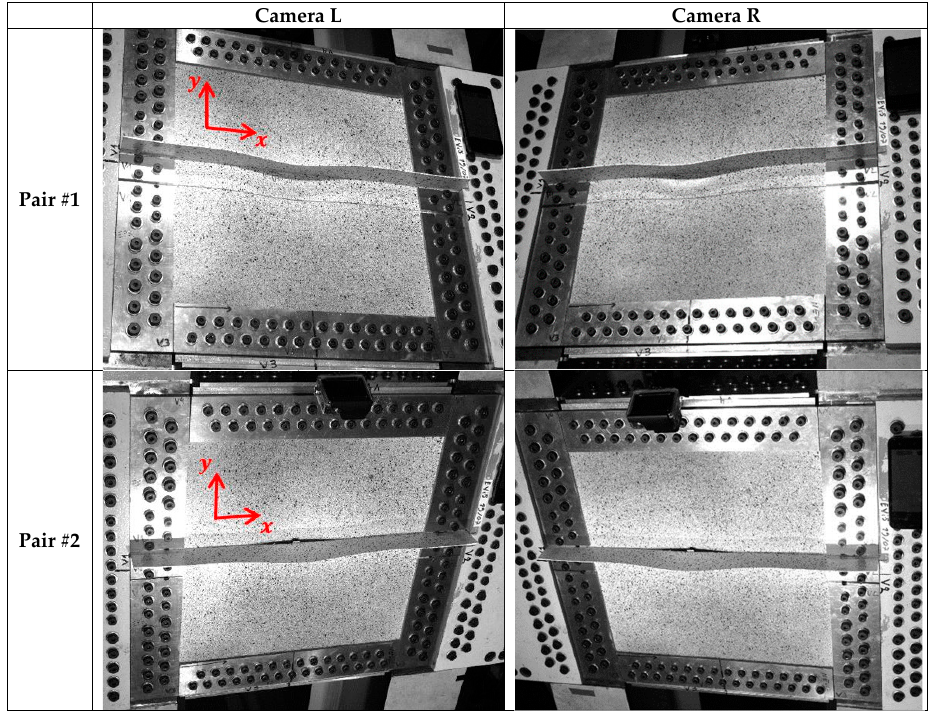
Figure 21. Points of view of the two pairs of cameras used for stereo-correlation, looking down onto Sample1 between the first debonding and the main debonding-tunnelling.